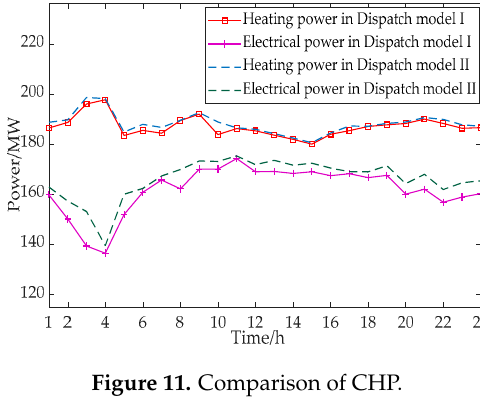
Figure 11. Comparison of CHP.